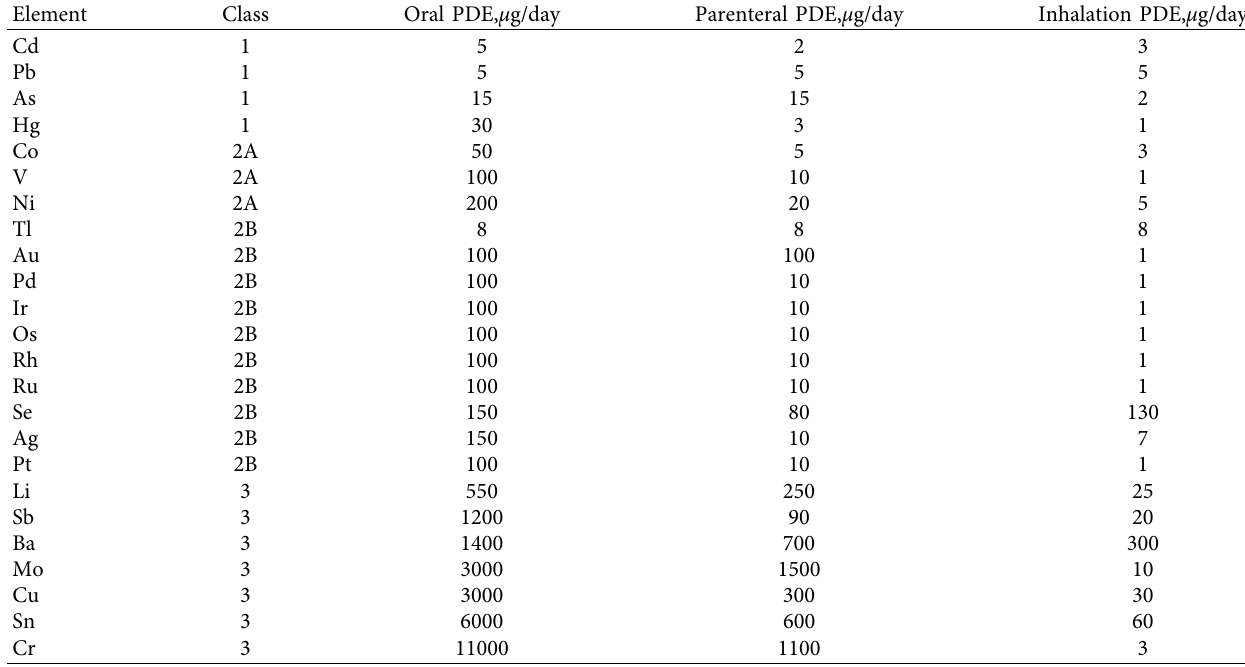
Table 1: Permitted daily exposures for elemental impurities established in ICH